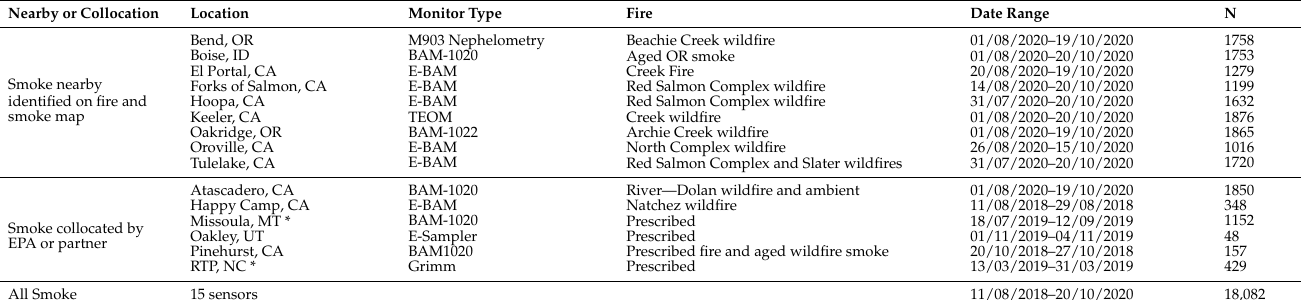
Table 2. Smoke-impact summary of the hourly averaged smoke-impacted dataset locations, monitor types, fires, date ranges, number of data points (N), concentration, and RH range. All PurpleAir sensors have >99% of the RH data present. Some sensors were collocated, while others were nearby sensor monitor pairs identified on the fire and smoke map. Most datasets are 2–3 months long, including both the smoke-impacted time and some typical ambient